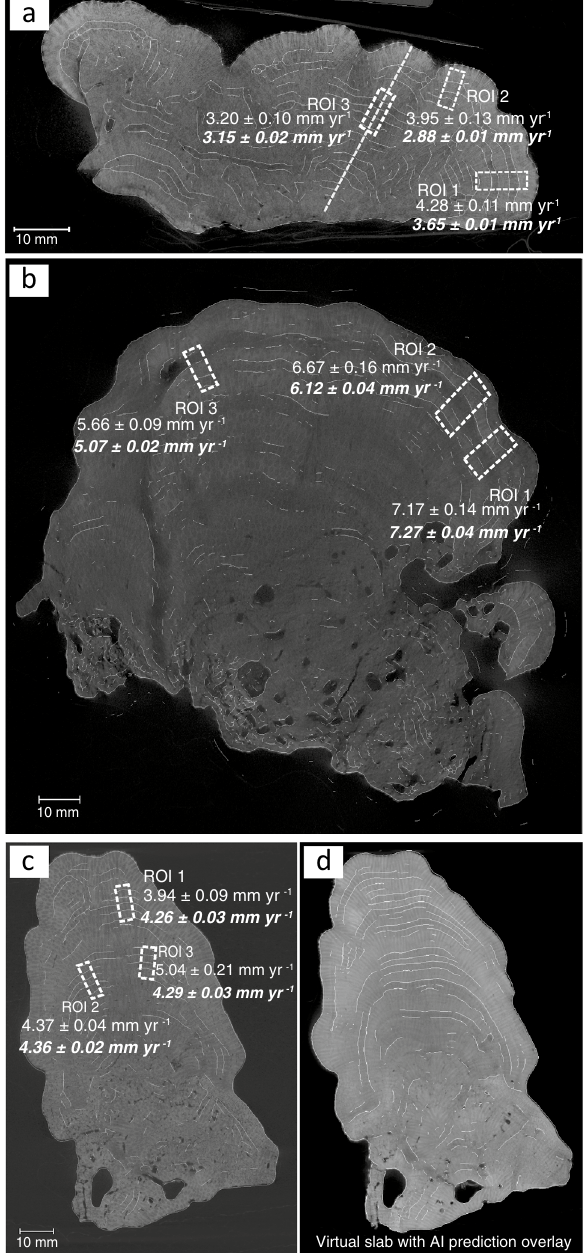
Fig. 2 Images of different high-resolution X-ray µCT scan slices (panels a-c) with predicted high- and low-density boundaries from CNN superimposed (thin white lines from stitched patches). Paired values are the mean annual extension rates calculated within regions of interest (ROI, white rectangles) from both manual point measurements (top value of pair) and CNN-generated bands (lower values in bold italics ) and their respective standard errors of the mean. a NHM Porites scan RS0030. b NHM Porites scan RS0116. c NHM Porites scan RS0128 (See Table S2 for tabular-arranged data). d A 3-mm-thick slab made of ~ 30 µCT slices from NHM Porites scan RS0128 and predicted density boundaries from our slice-only trained CNN superimposed as white lines (see SI and Fig. S8 for